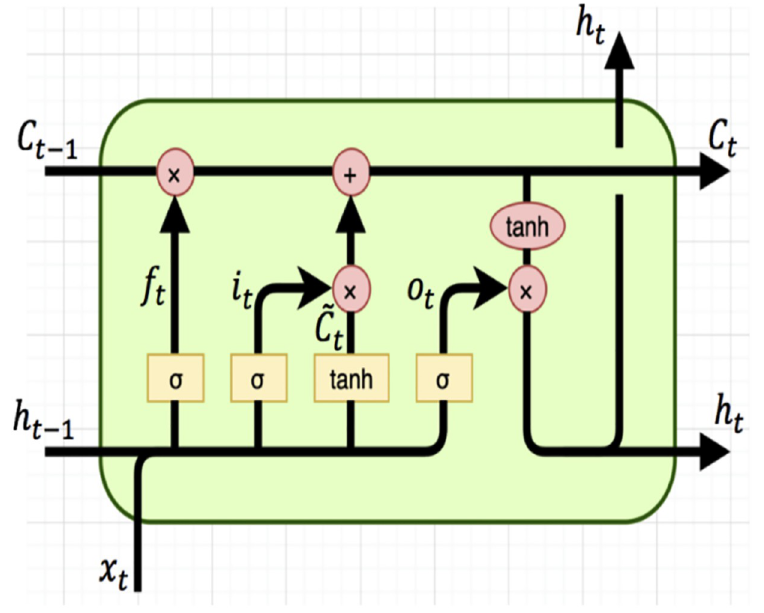
Fig 2. Architecture of an LSTM unit